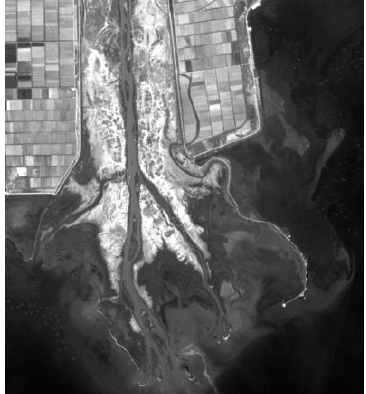
details as areas of low vegetation, cultivations, roads, riverbed boundaries and highlights the changes in image intensity detecting boundaries of similar